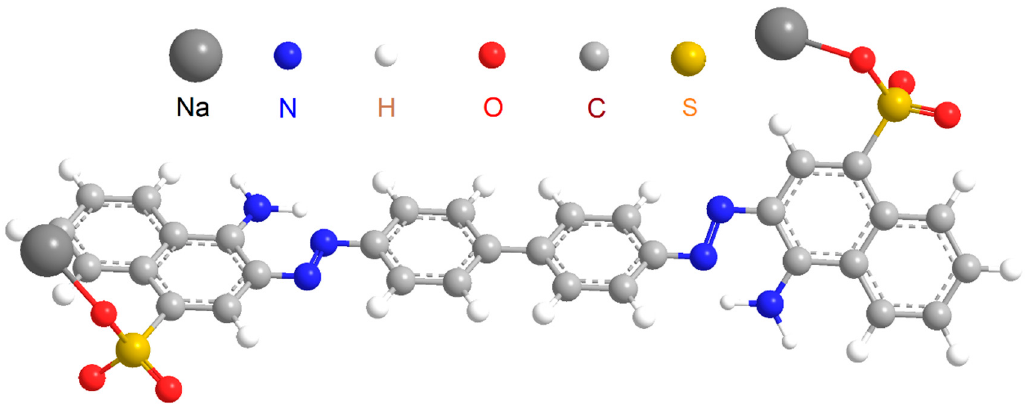
Figure 1. Molecular structure of the Congo red dye.